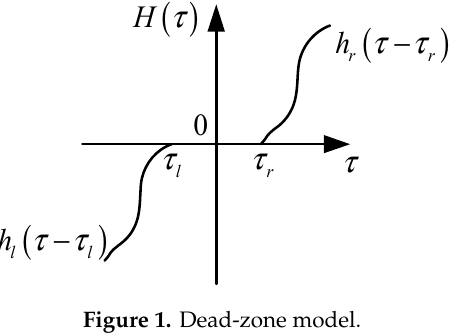
Figure 1. Dead-zone model.